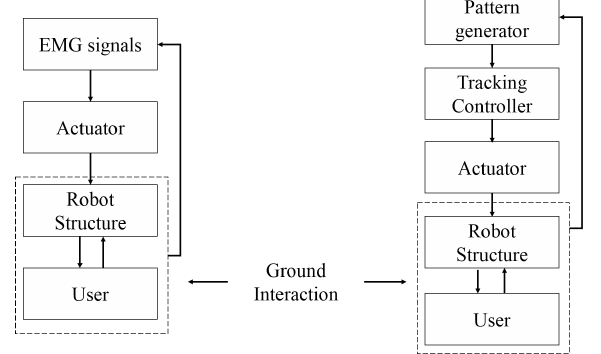
Figure 1. Block diagram in a control system using a gait pattern generator and EMG signals adopted from